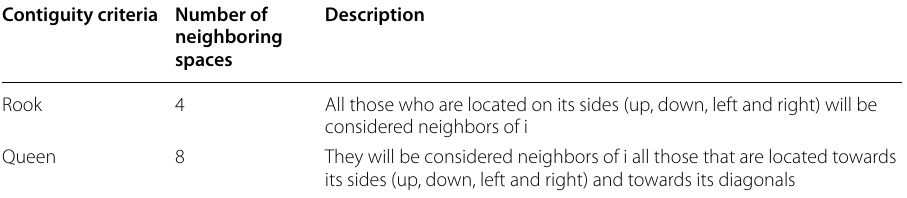
Source: Anselin and Rey (2014)